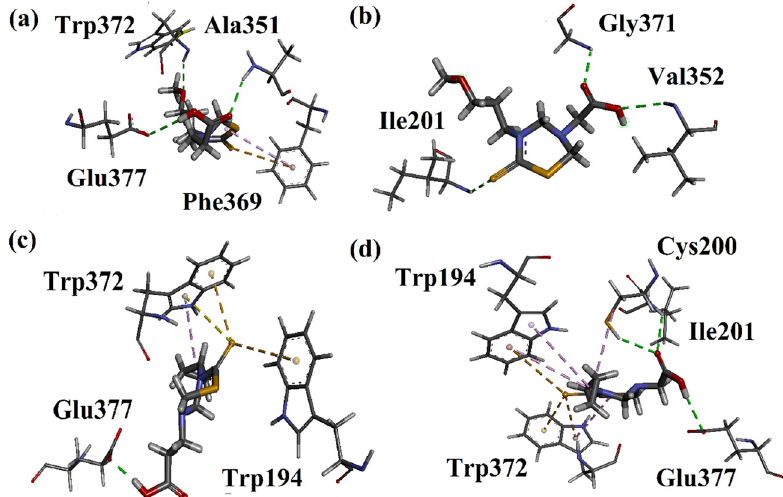
Figure 3: ( a – d ) 3 - D interaction plots of compounds 3 – 6 modeled by using Discovery Studio Visualizer in the binding site of iNOS ( PDB ID = 4NOS )